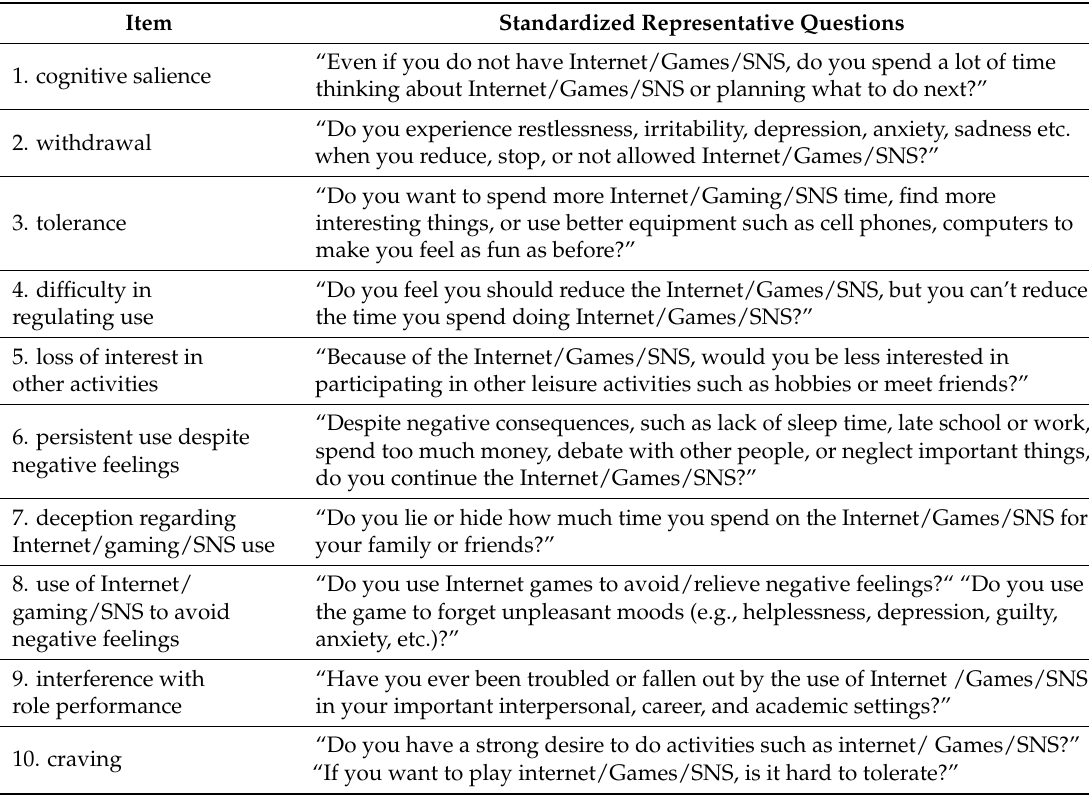
Table 1. Examples of standardized interview script in Diagnostic Interview for Internet Addiction.